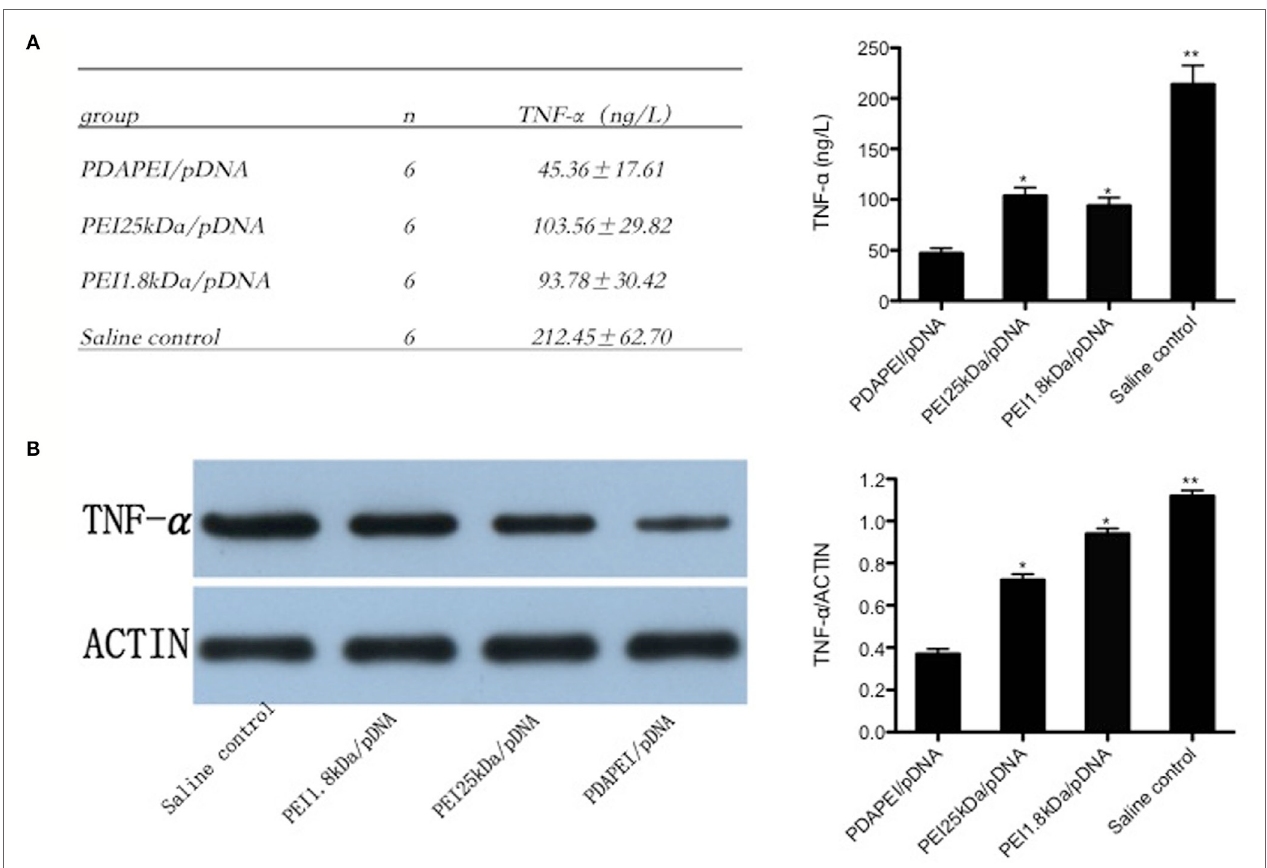
FigUre 6 | TnF- α expression in synovial fluid of the knees . (a) TNF- α levels in synovial fluid of the knees from four groups (PDAPEI/pDNA, PEI 25 kDa/pDNA, PEI 1.8 kDa/pDNA, and saline control group) were determined by enzyme-linked immunosorbent assay (ELISA). Values are the mean and SEM from six different mice. (B) Western-blot analysis of TNF- α levels in synovial fluid of the knees ( n = 6 in each group, * p < 0.05, ** p <